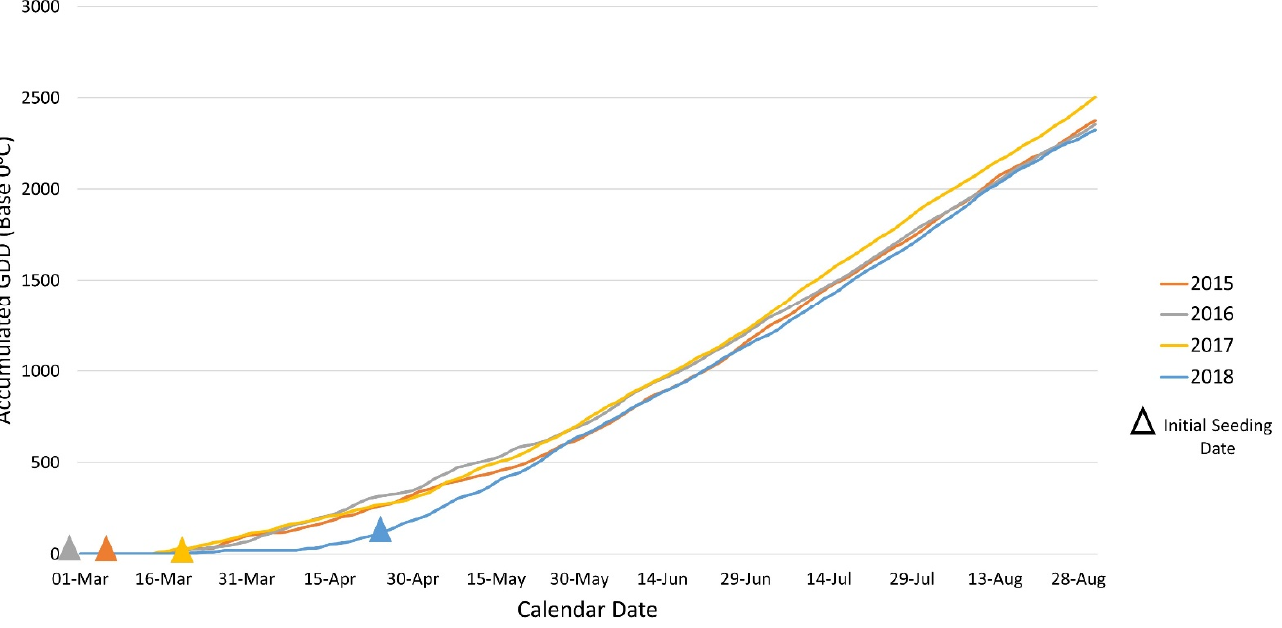
Figure 2. Growing degree day (base 0 °C) (GDD B 0 ) accumulation at the Lethbridge, Alberta sites, 2015–2018. The position of each triangle indicates the initial seeding date in each year in relation to GDD B 0 accumulation for the growing season (March 1 to September 1).